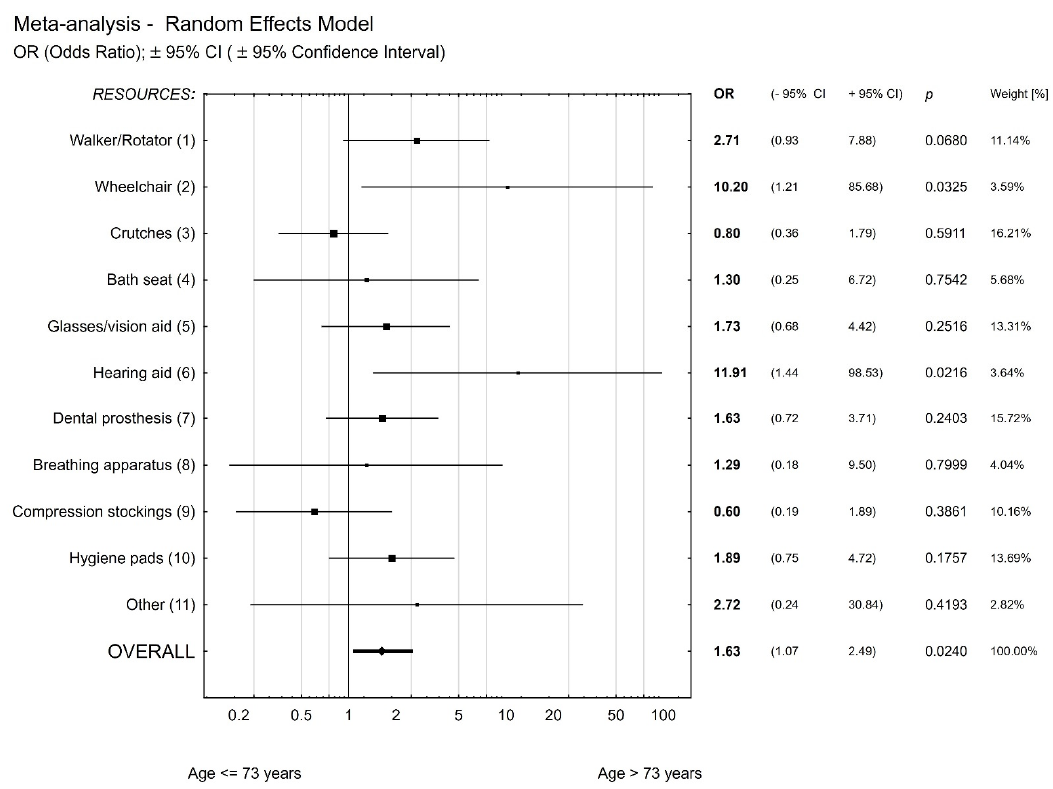
Figure 1. Likelihood of the use of assisting means in people 73+.